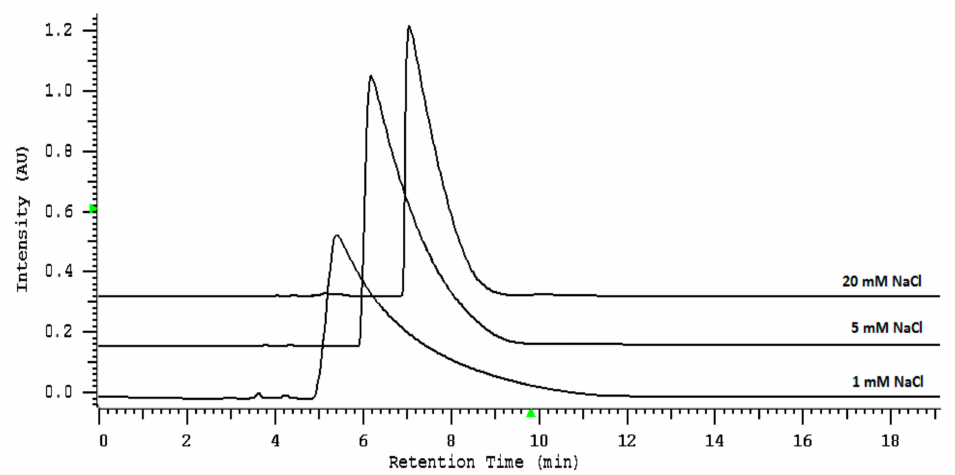
Figure 1. The influence of NaCl concentration in the mobile phase in the range of 1 to 20 mM for the thiocyanate retention, the peak symmetry, and the e ffi ciency. The column: IAM.PC.DD2 Regis HPLC Agilent Technologies, flow rate of the mobile phase: 0.5 mL / min, injected volume: 10 µ L, and analytical wavelength: 210